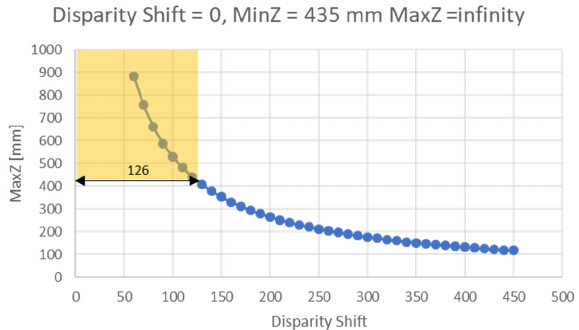
Figure 4. The graph shows the maximum acquirable depth as a function of the disparity shift, calculated considering the HFOV of the camera under investigation (67.24°).